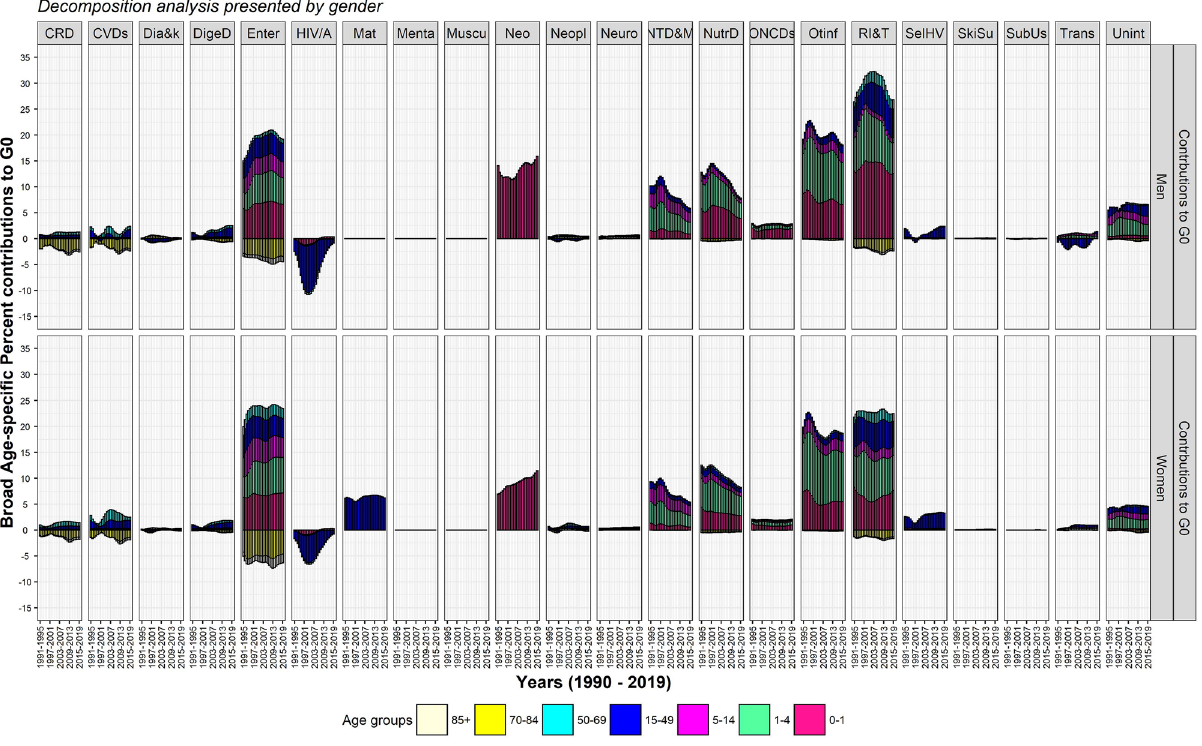
Figure 9. Temporal changes in age-cause-specific contributions to ΔG 0 , men and women, India, 1990–2019. CRD , chronic respiratory diseases, CVDs cardiovascular diseases, Dia&k diabetes and kidney diseases, DigeD digestive diseases, Enter enteric (diarrhea and typhoid) infections, HIV/A HIV/AIDS and STI, Mat maternal disorders, Menta mental disorders, Muscu musculoskeletal disorders, Neo neonatal disorders, Neopl neoplasms, Neuro neurological disorders, NTD&M neg. tropical diseases and malaria, NutrD nutritional deficiencies, ONCDs other noncommunicable diseases, Otinf other infectious diseases, RI&T respiratory infections and tuberculosis, SelHV self-harm and interpersonal violence, SkiSu skin and subcutaneous diseases, SubUs substance use disorders, Trans transport injuries, Unint unintentional